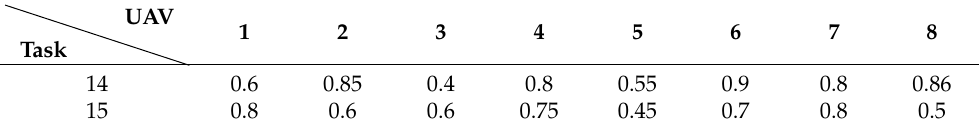
Table 10. UAV detection capability